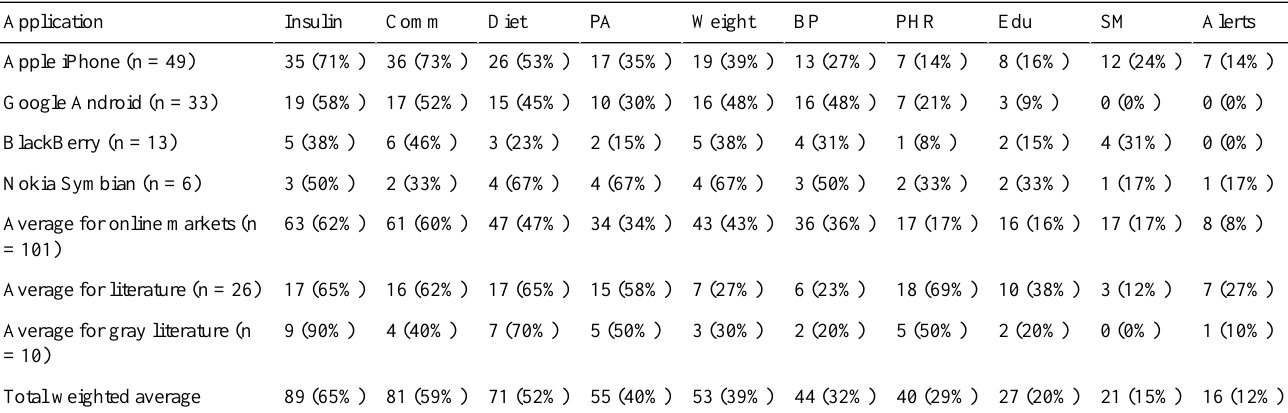
Table 1. Numbers and percentages of applications (n = 137) with the respective features of insulin, communication (Comm), diet, physical activity